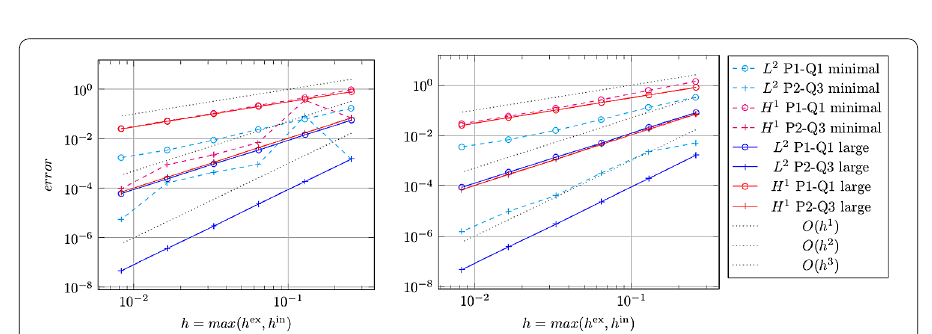
Figure 9 Definition of γ in . Adaptive definition of γ in in the case of minimal overlap between (cid:9) in Note that, γ ex (magenta) remains fixed, while γ in (red) changes due to the refinements in (cid:9) in edges of elements of T ex and T in are omitted for clearness